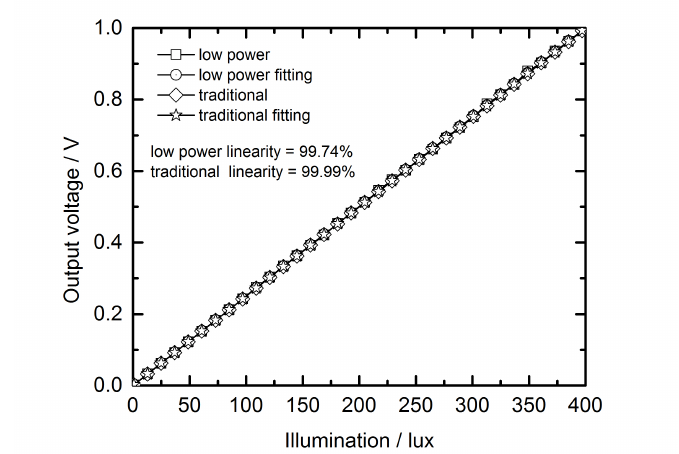
Figure 13. Linearity simulation results of the two versions.